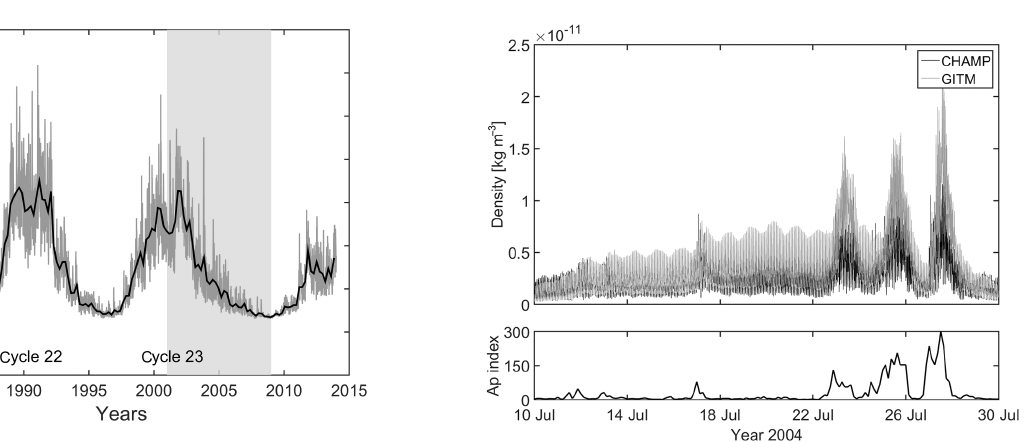
Figure 5. Effect of the geomagnetic storminess on GITM and CHAMP neutral densities from 10 to 30 July 2004. Table 1. Boundary conditions of the